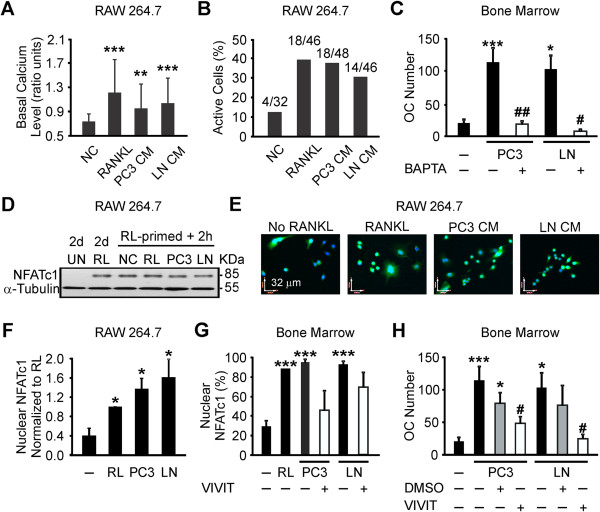
Prostate cancer-derived factors induce calcium/NFATc1 signaling in osteoclast precursors. A, B) RANKL-primed RAW 264.7 cells were loaded with fura-2-AM, cultured for 15 min untreated (negative control), with 50 ng/ml RANKL, or 10% PC3 or LNCaP CM, and imaged for 2 min. A) Average basal calcium levels. Data are means ± SD; n = 32-48 cells per condition; *significance compared to negative control as assessed by Student’s t-test. B) Percentage of active cells classified as having standard deviation of basal calcium above 0.05. C) RANKL-primed bone marrow precursors were pre-treated with 50 μM BAPTA (white bars) and exposed to 10% PC3 or LNCaP CM for 2 days, and average number of osteoclasts was assessed. Data are means ± SEM; n = 3-7 experiments; *significance compared to negative control; #significance compared to no inhibitor. D, F) Protein was extracted or samples were fixed from untreated or RANKL-primed RAW 264.7 cells, or RANKL-primed precursors cultured for 2 h untreated, with RANKL, or with 10% PC3 or LNCaP CM. D) NFATc1 protein levels, α-tubulin as a loading control. E) NFATc1 localization (green); nuclei were counterstained using DAPI (blue). F) Average NFATc1 nuclear localization normalized to the continuous RANKL (RL) treatment. Data are means ± SEM; n = 3 experiments. G, H) RANKL-primed bone marrow cells were pretreated with 0.1% DMSO vehicle (grey bars), or 50 μM NFAT inhibitor VIVIT (white bars), and cultured untreated, treated with RANKL, or with 10% PC3 or LNCaP CM for 2 h to examine NFATc1 localization; or 2 days to assess osteoclast formation. G) Average percentage of cells with nuclear NFATc1. Data are means ± SEM; n = 3 experiments. H) Average number of osteoclasts. Data are means ± SEM; n = 3-7 experiments; *significance compared to negative control, #significance as compared to no inhibitor.